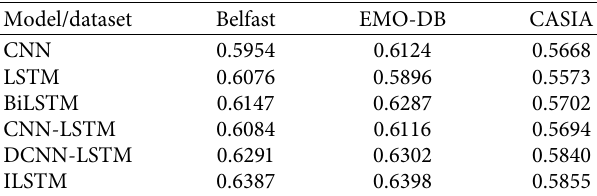
Table 7: Precision of different models on each dataset.